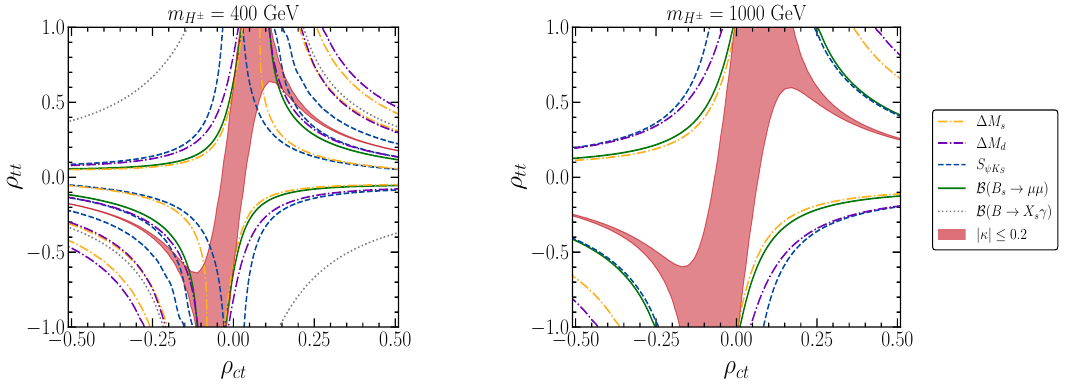
Figure 4 . B sector and ε K constraints in ρ ct – ρ tt plane for m lines indicate 2 σ range of experimental data, outside of which are ruled out . The filled red band corresponds to the region allowed by ε NP